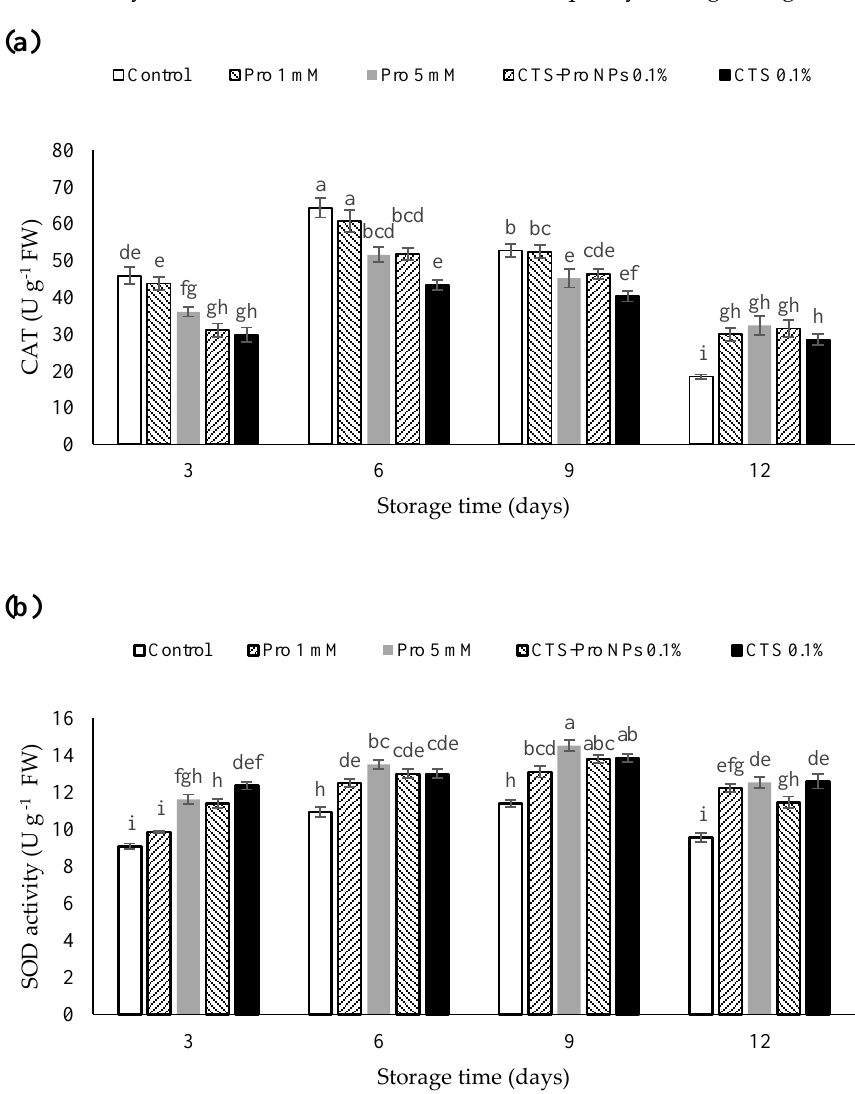
Figure 4. Effect of post–harvest treatments of strawberries with Pro, CTS and CTS–P NPs on activities of CAT ( a ) and SOD ( b ) during 12 days of storage at 4 ◦ C. Data presented are mean ± SE of three replications. Different letters (a–i) over bars indicate they are significantly different ( p < 0.05) by Duncan’s test.